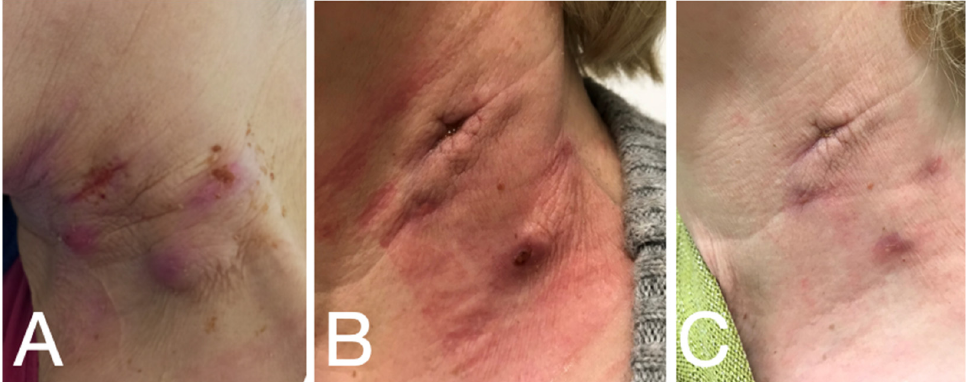
Figure 1. Clinical course of the lymph node extirpation. ( A ) initial presentation; ( B ) upon transfer to our hospital; ( C ) one month after treatment with ciprofloxacin. to our hospital; ( C ) one month after treatment with